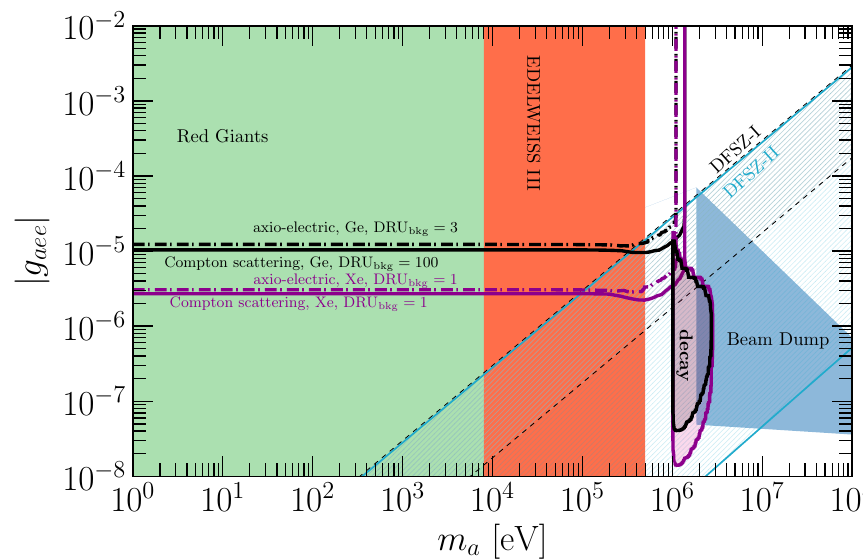
Figure 11 . Electron-ALP coupling 90% CL sensitivities along with relevant laboratory and astro- physical limits that apply in the region of interest. Black contours correspond to 90% CL sensitivities achievable with ongoing or near-future experiments (see table 2). Purple contours instead indicate 90% CL sensitivites that could be achieved in a next-generation xenon detector. Solid (dashed- dotted) contours refer to sensitivities under the assumption of detection via inverse Compton-like scattering (axio-electric absorption) and different background rates. See the text for more